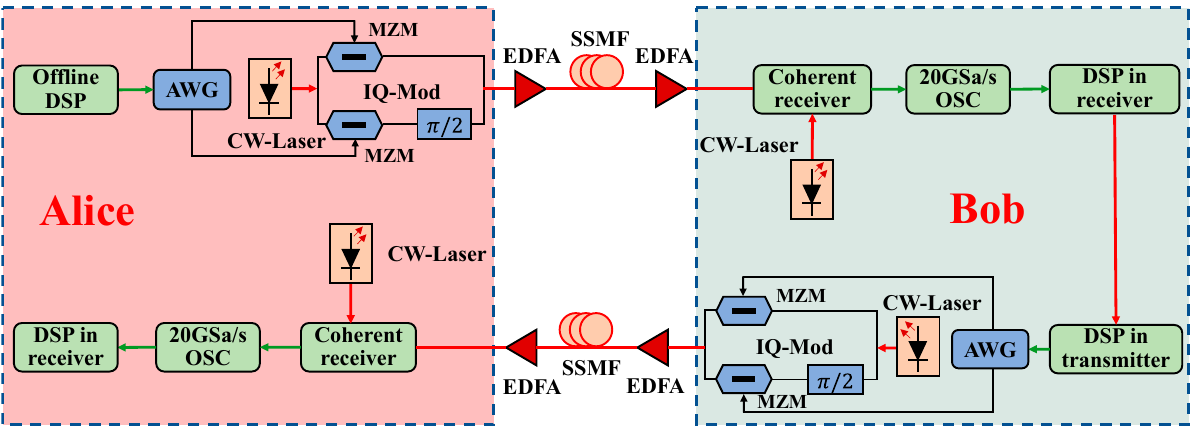
Figure 4. System simulation platform. MZM: Mach–Zehnder modulator. SSMF: standard single mode fiber. Table 1. Simulation parameter list.